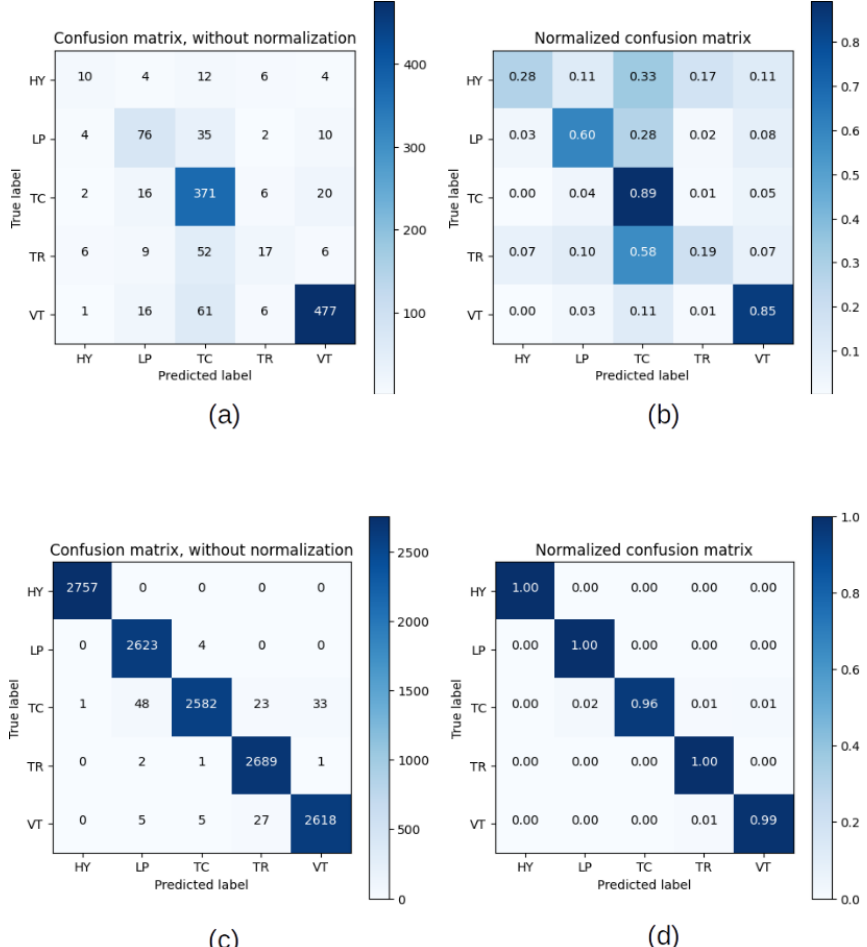
Figure 9. Confusion matrices without normalization (a) and normalized (b) , for experiment (i), and without normalization (c) and normalized (d) , for experiment (ii). Table 6. Performance of the transfer learning experiments for the experiment to 1–20 [Hz]. Experiments/metrics Accuracy F1 Recall Precision Cohen’s kappa Class accuracy